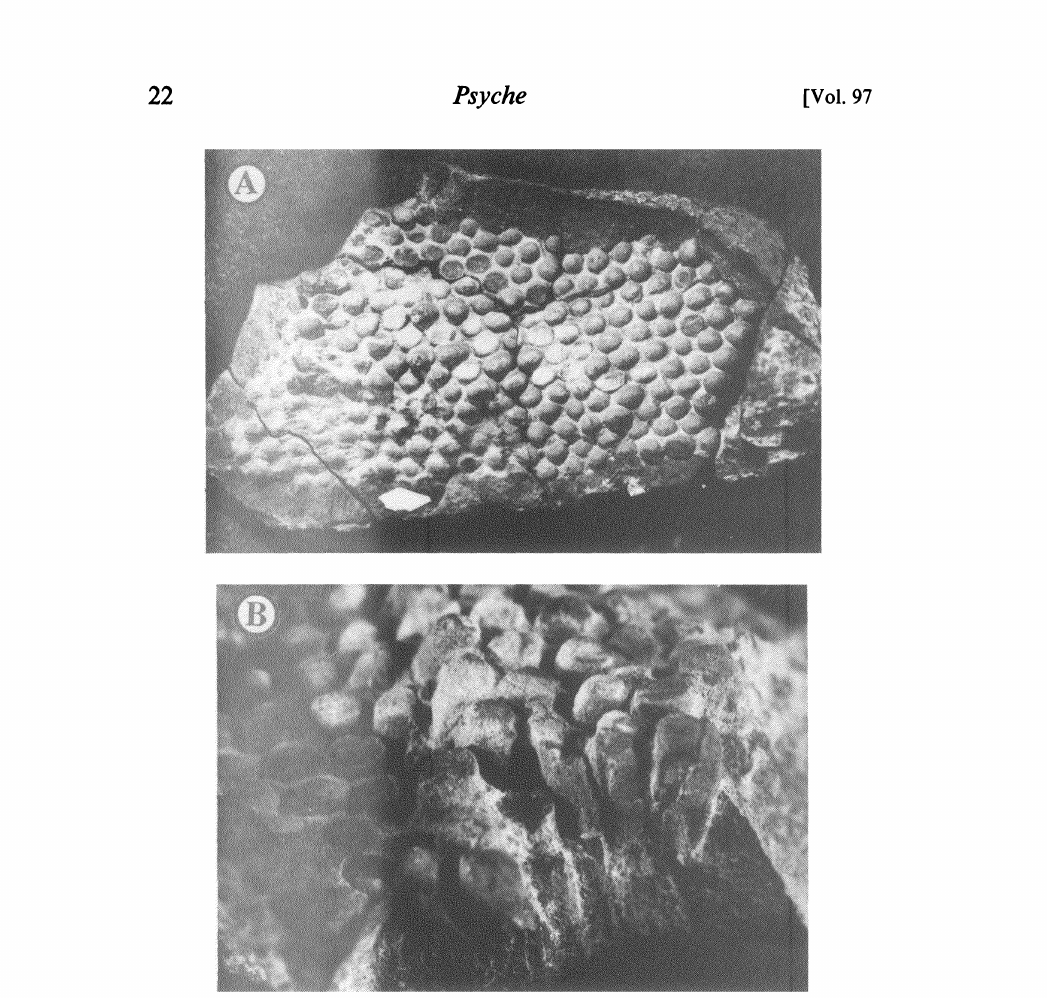
Figure 1. Celliformafavosites. A. Primary face of split nodule showing cells and intervening matrix viewed from above. B. Cells revealed in side view by fracture in upper left of Fig. a, showing domed ends, domes widely separated at the comb back (upper region) and drawing nearer each other at the comb face (lower